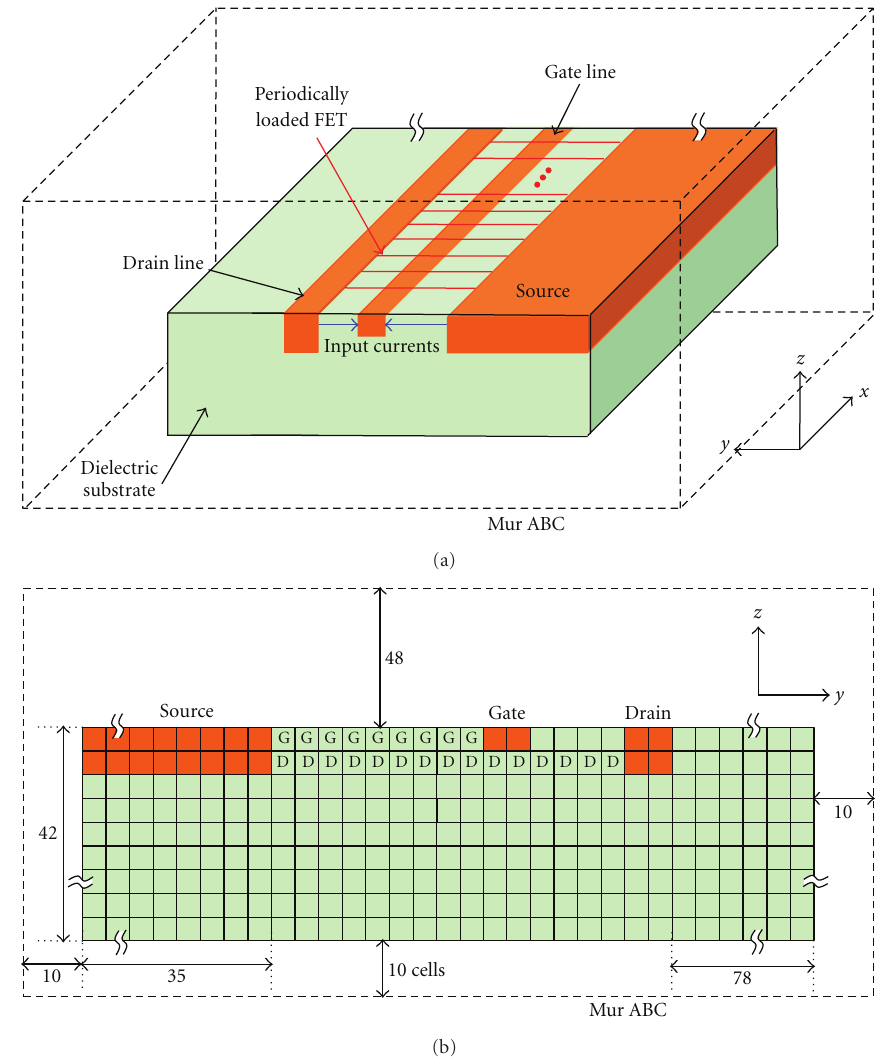
Figure 4: Setup of FDTD calculations. (a) The longitudinal and (b) the transverse structure of the calculated TWFET.